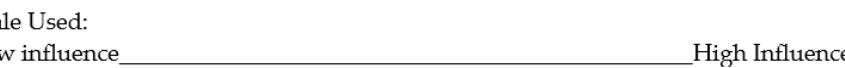
Figure 2. Exercise Figure 2. Exercise scale.